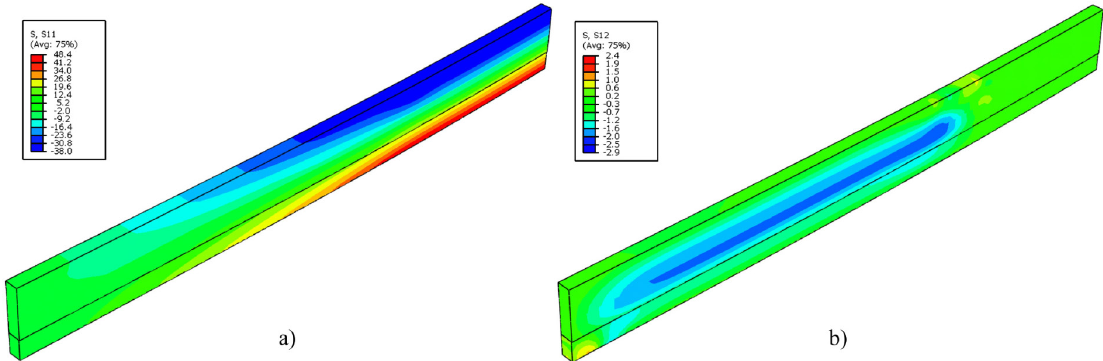
Fig. 11. Stress (MPa) distributions in glulam at ultimate load for Series E beams: a) normal σ 11 stress and b) shear σ 12 stress